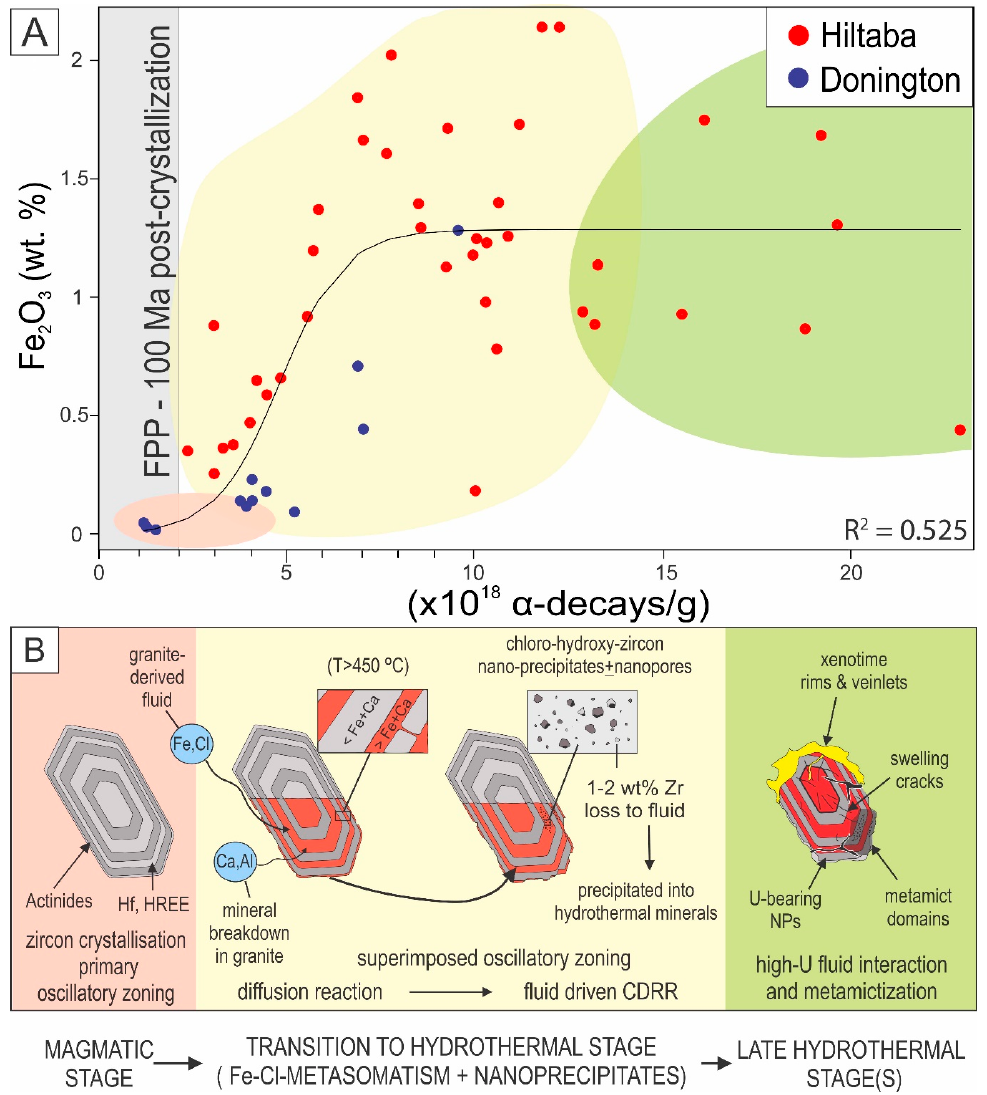
Figure 17. ( A ) Plot of Fe 2 O 3 (wt.%) versus D c ( × 10 18 α -decays/g) for all zircon samples as marked and using EPMA data from Supplementary Materials B, Table S4 (four analyses with D c > 25 were excluded). A sigmoid through the data was fit by non-linear least squares regression using the software “R”. Although the first percolation point (FPP) for zircon was marked at D c = 2 (as defined by Salje et al. [48]), a sharp increase in wt.% Fe 2 O 3 was seen only at D c = ~3. The FPP in Olympic Dam zircon was only reached at least 100 Ma after crystallization, using the dose concentration calculation of Meldrum et al. [58]. Also, note the scatter in the dataset concordant with the weak correlation between the highest measured non-formula element (Fe) and D c . ( B ) Schematic diagram illustrating evolution of magmatic zircon from granites in the Olympic Cu–Au Province. Colored areas in ( A ) correspond to the main evolutionary stages in ( B ). Note that Cape Donington zircon, with the lowest non-formula elements, plots in a magmatic domain that straddles the FPP line. In contrast, analyses with high U concentration corresponded to intensively altered stages (green), featuring superimposed textures with all the characteristic of metamict zircon, possibly resulting from interaction with late-stage, U-rich hydrothermal fluids. Metasomatic textures and association with abundant, Cl-rich nanoprecipitates are typical features of fertile granites. The association between Fe and Cl recorded in metasomatized zircon during magmatic-to-hydrothermal transition is a diagnostic signature of fertile IOCG